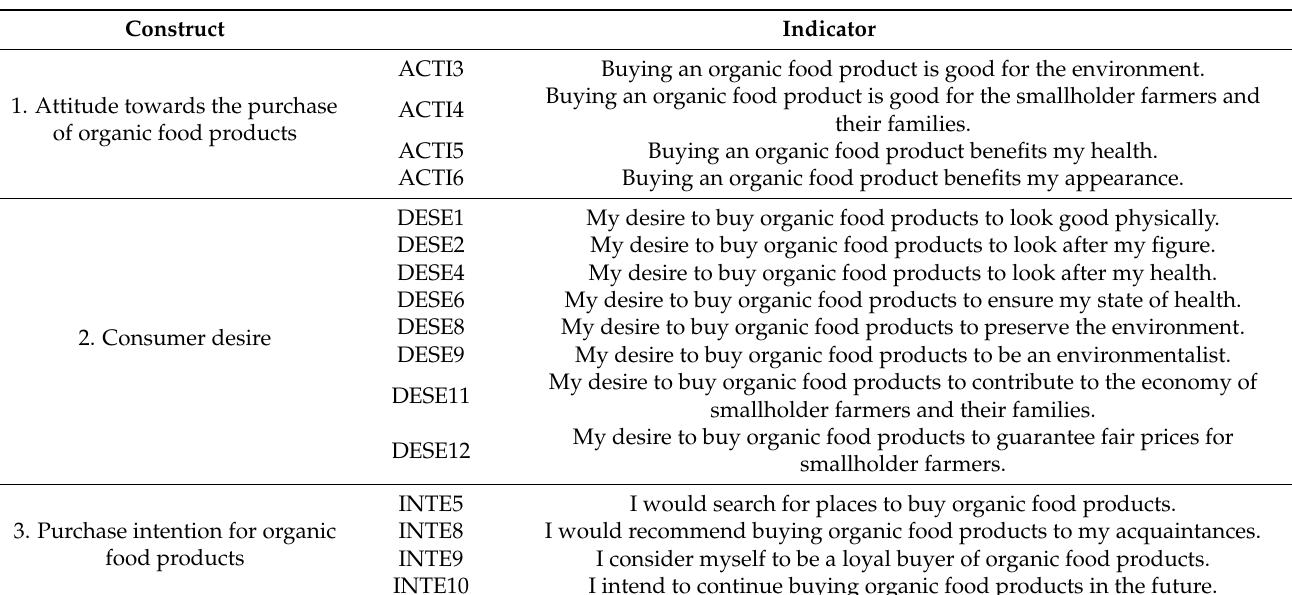
Table 2. Constructs and their